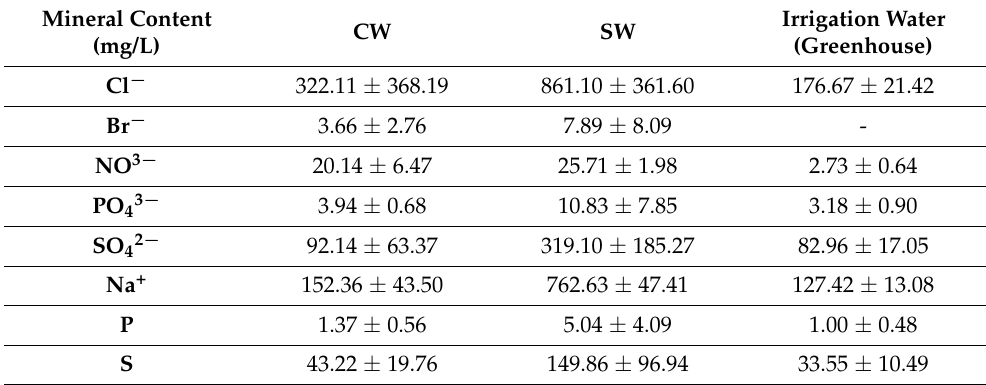
Table 2. Chemical composition of the irrigation water compared to the control water.